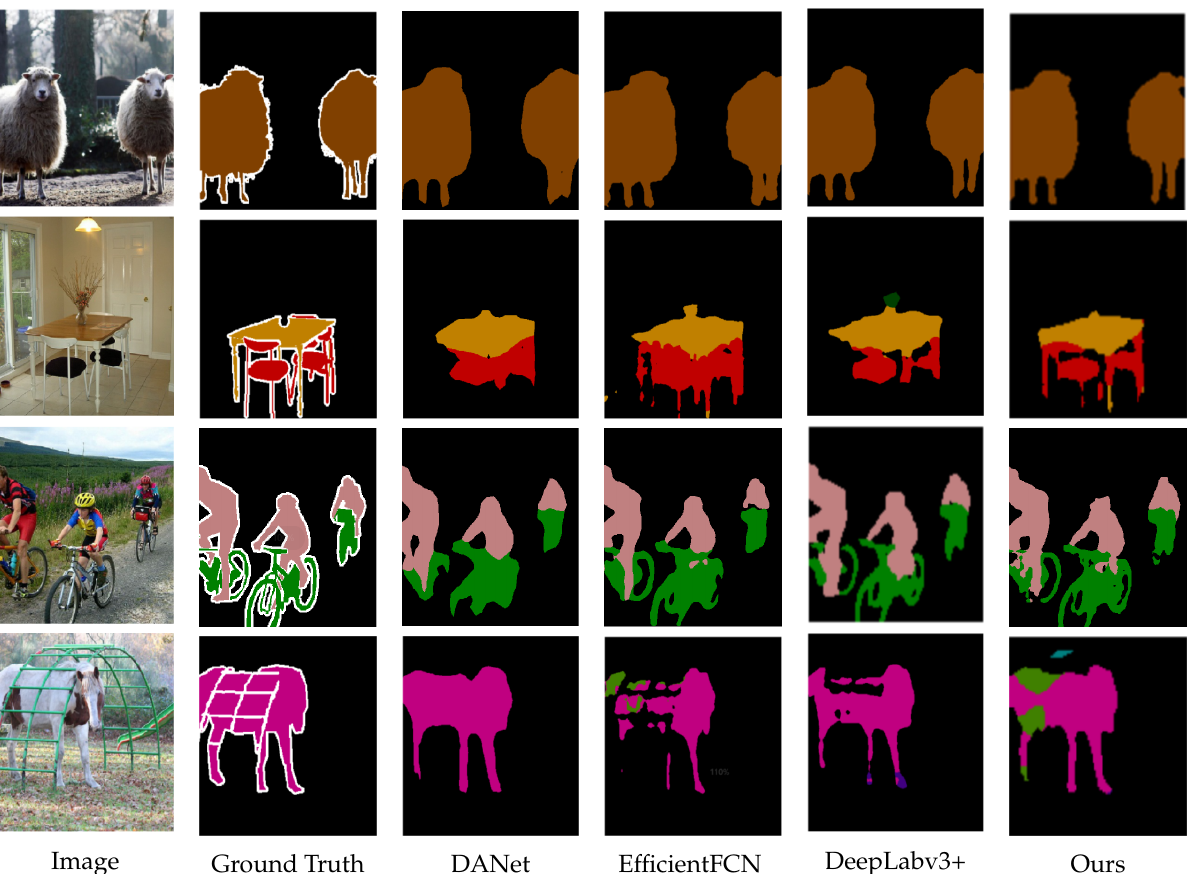
Figure 7. Visual comparison on PASCAL VOC 2012